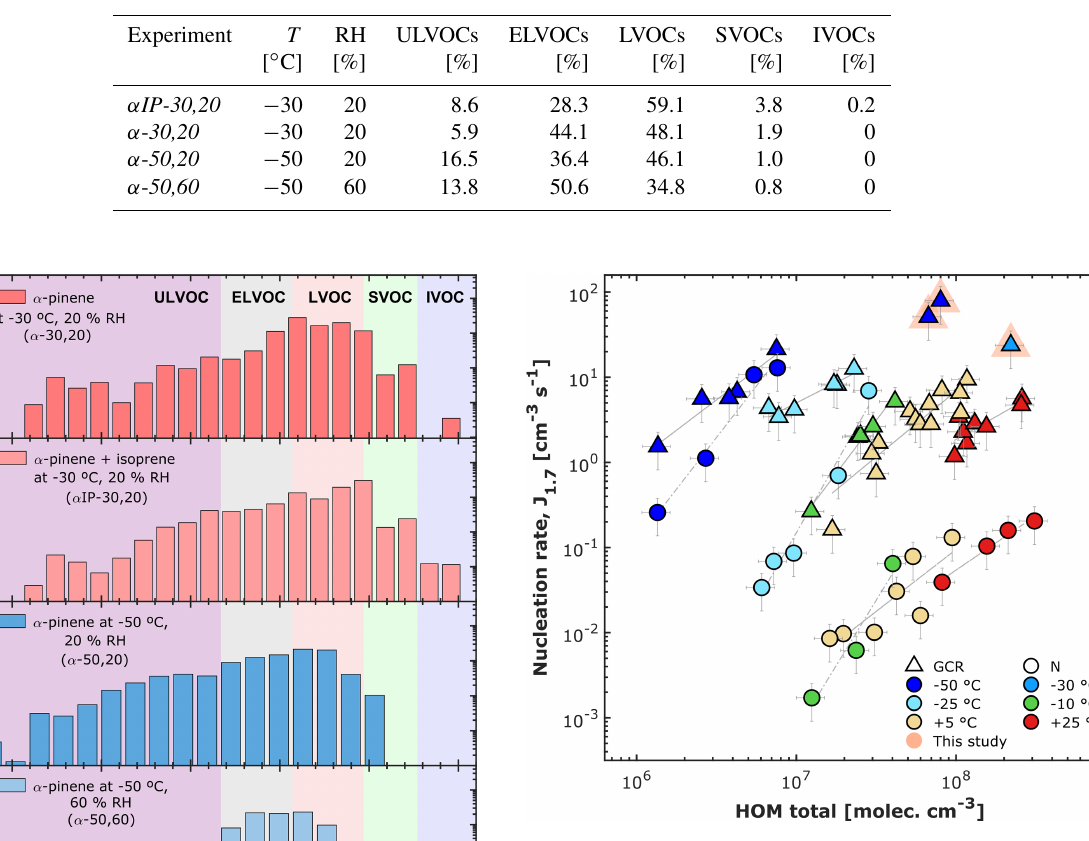
Figure 6. Pure biogenic nucleation rates of pure α -pinene at 1.7nm diameter against total HOM concentration at different temperatures. The HOM total is defined as the sum of C 5 , C 10 , C 15 and C 20 car- bon classes. Triangles represent galactic cosmic ray (GCR) condi- tions, and circles represent neutral conditions. Data points at − 50, − 25, − 10, + 5, and + 25 ◦ C are from Simon et al. (2020). The points with orange marker on the background are the contribution of this study (experiments α -30,20, α -50,20 and α -50,60). Solid and dashed lines represent power-law fits to GCR and neutral con- ditions. Bars indicate 1 σ run-to-run experimental uncertainty. The overall systematic-scale uncertainty of HOMs of + 78% and − 68% is not